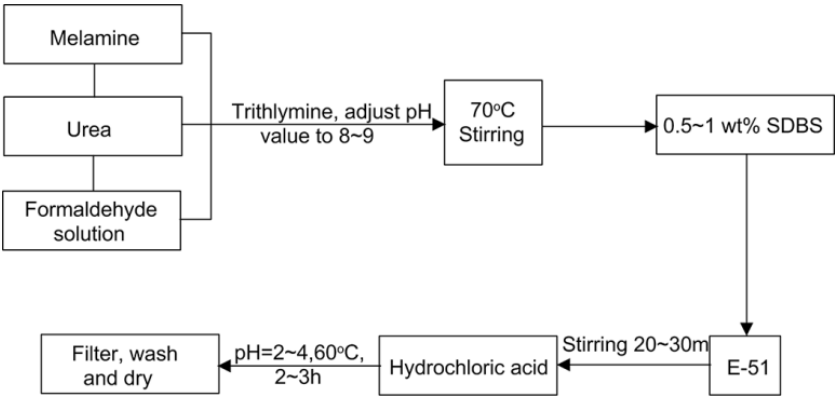
Figure 1. Synthesis procedure of microcapsules.